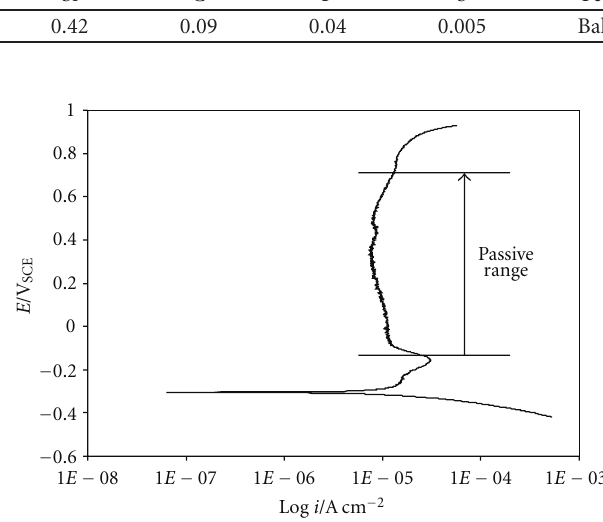
Figure 1: Potentiodynamic polarization curve of 316 in 0.05M H 2 SO 4 solution with 1 mV/s scan rate.